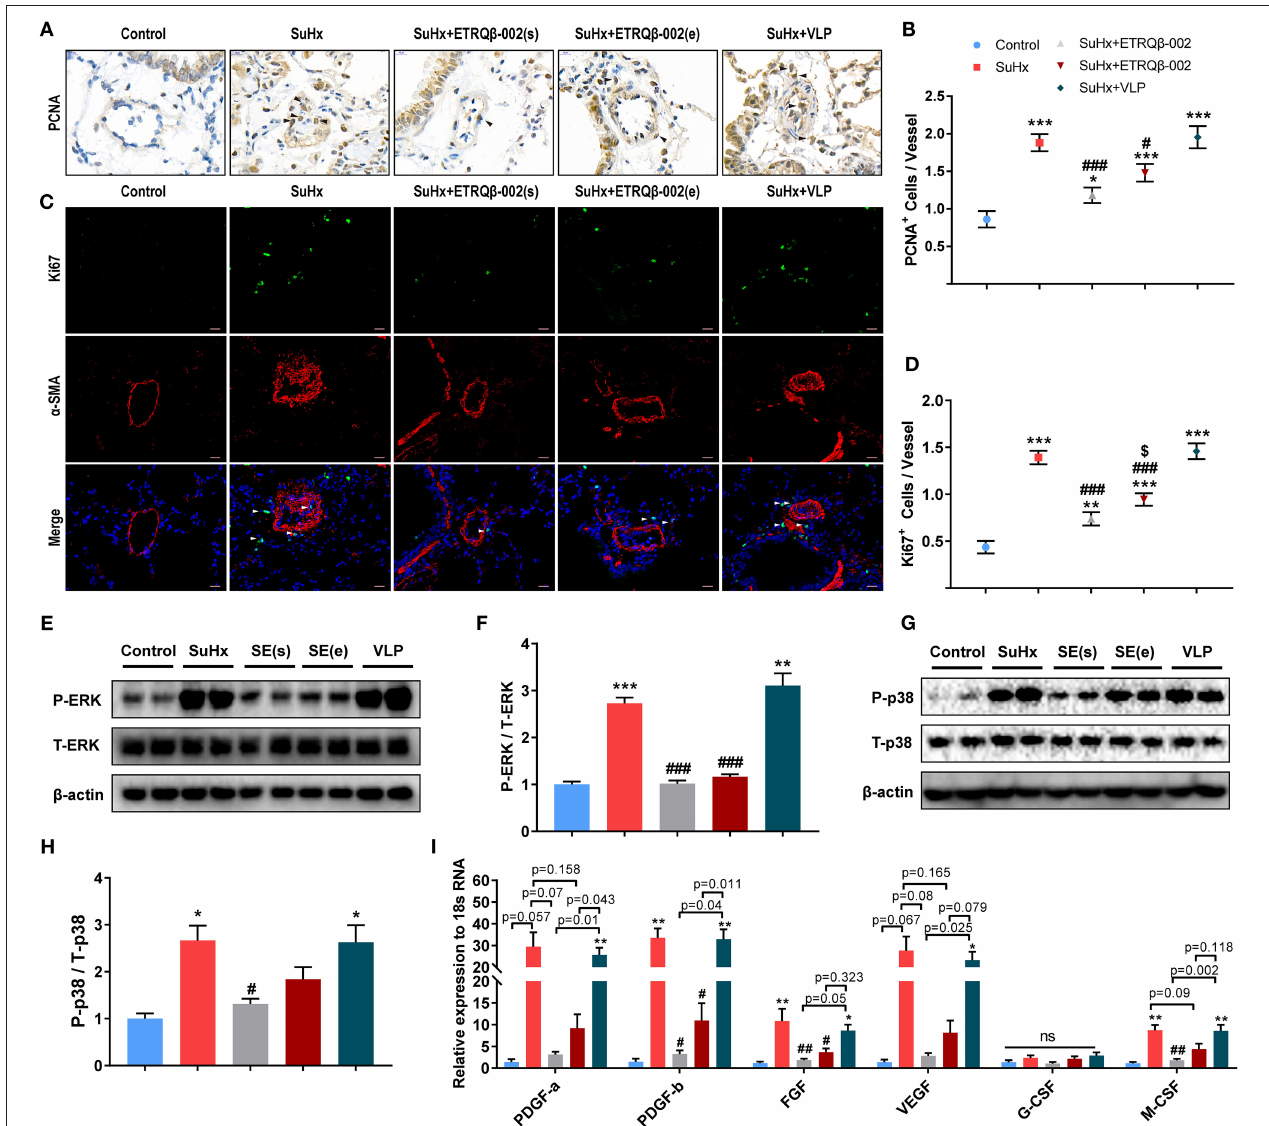
FIGURE 2 | ETRQ β -002 vaccine effectively reduced proliferation response of PA in SuHx-induced PAH mice. (A) Representative photographs of PCNA immunohistochemistry staining of lung sections from each group (scale bar = 10 µ m). (B) The number of PCNA-positive cells in vessels and perivascular tissues ( n = 6). (C) Representative photographs of Ki67/ α -SMA double-immunofluorescence staining of lung sections from each group (scale bar = 20 µ m). (D) The number of Ki67-positive cells in vessels and perivascular tissues ( n = 6). (E,F) Representative immunoblot, corresponding densitometric analysis of pERK and total ERK ( n = 6). (G,H) Representative immunoblot, corresponding densitometric analysis of pp38 and total p38 ( n = 6). (I) Quantitative RT-PCR (qRT-PCR) analysis of growth factors in lung homogenate from five groups ( n = 4–5). The black and white arrows refer to the PCNA-positive cells and the Ki67-positive cells, respectively. All data